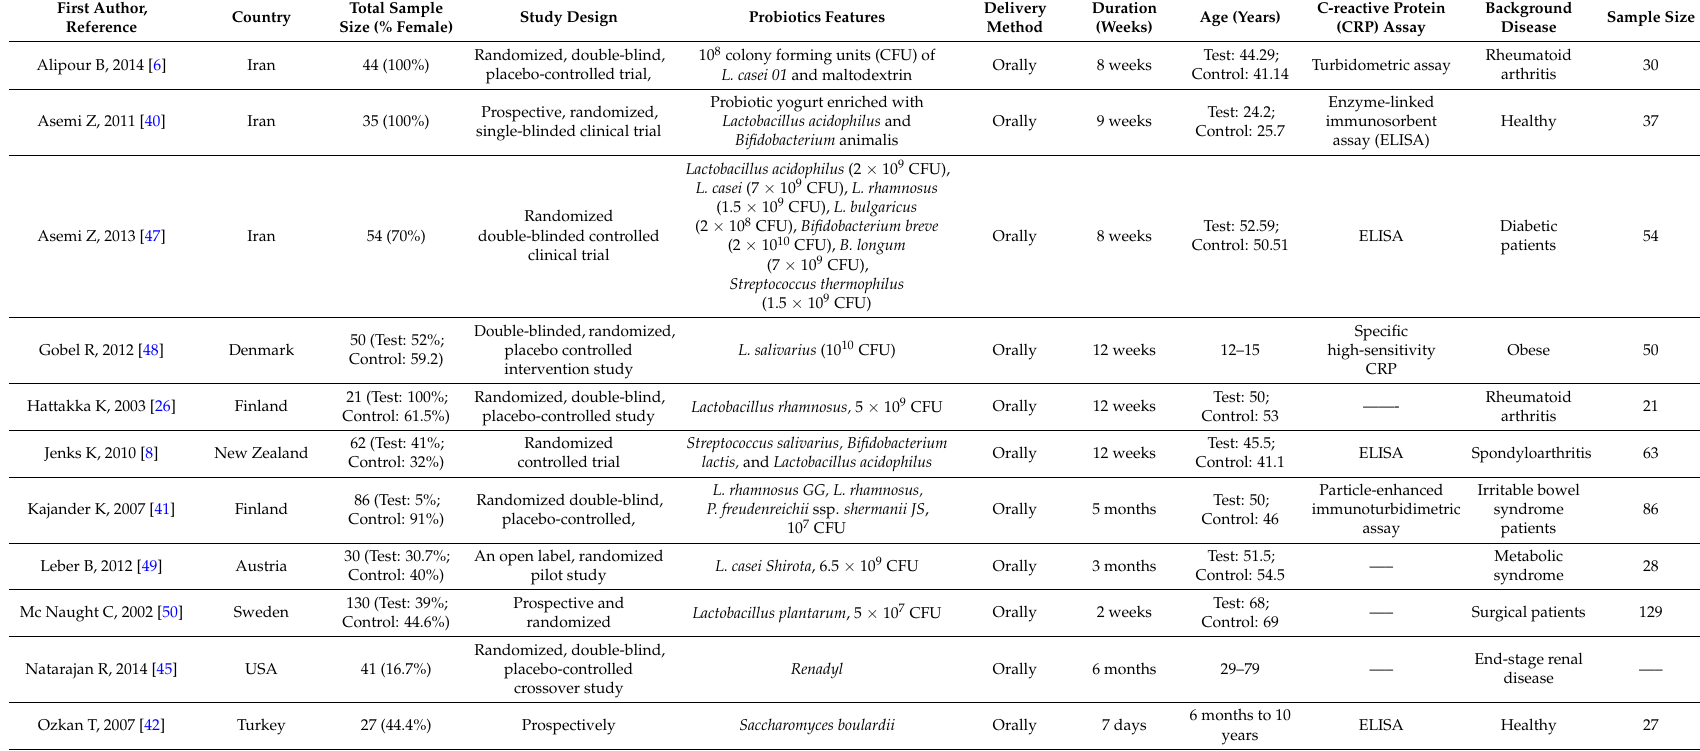
Table 1. General characteristics of the studies included in